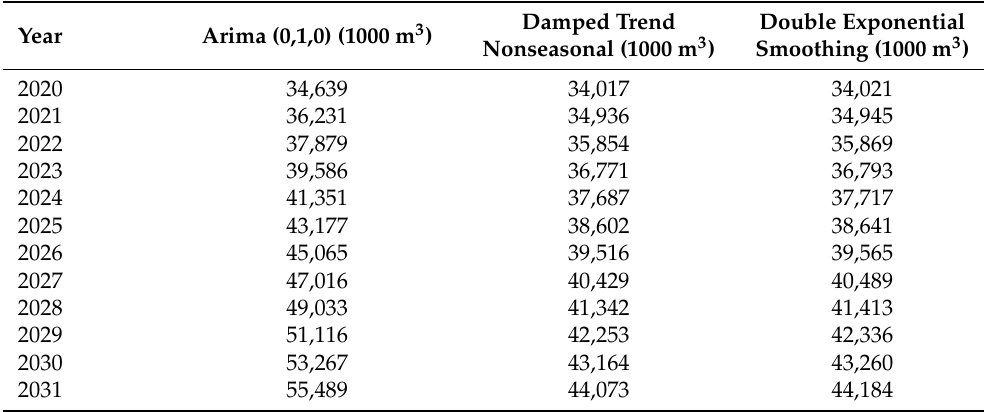
Table 3. Ethanol production forecast provided using Arima (0,1,0), Double Exponential Smoothing, and Damped Trend Nonseasonal